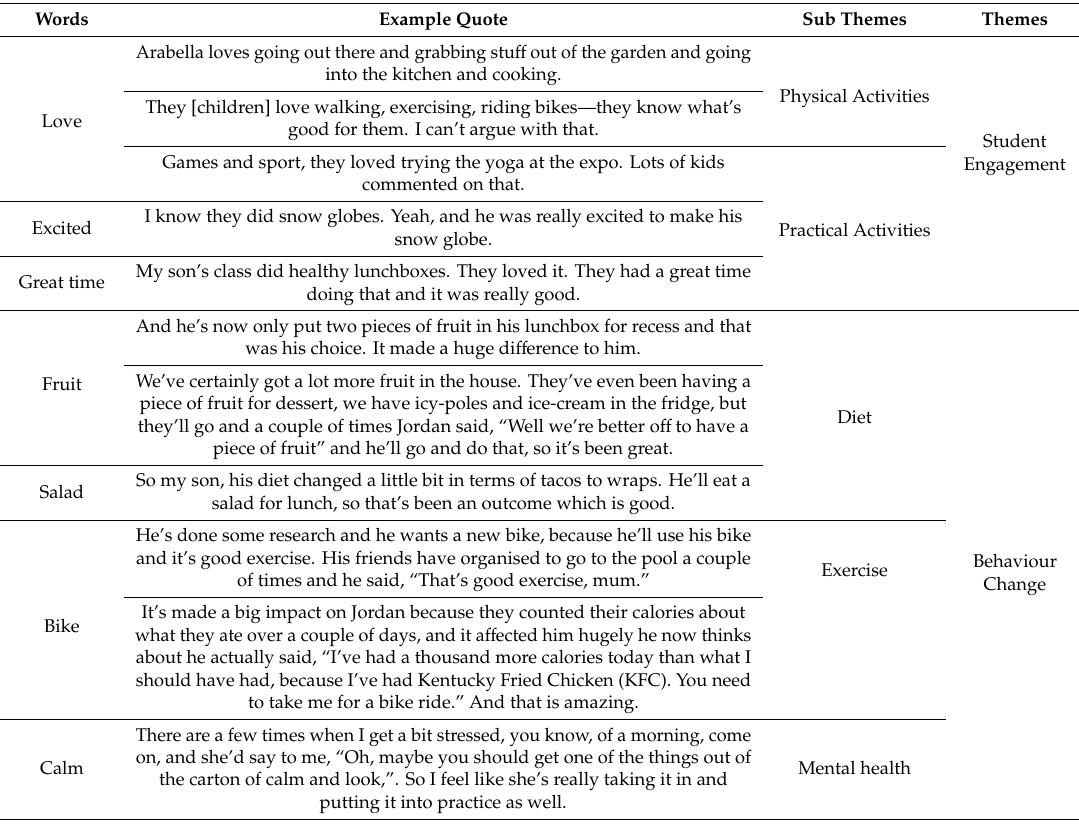
Table 2. Final themes and subthemes with supporting